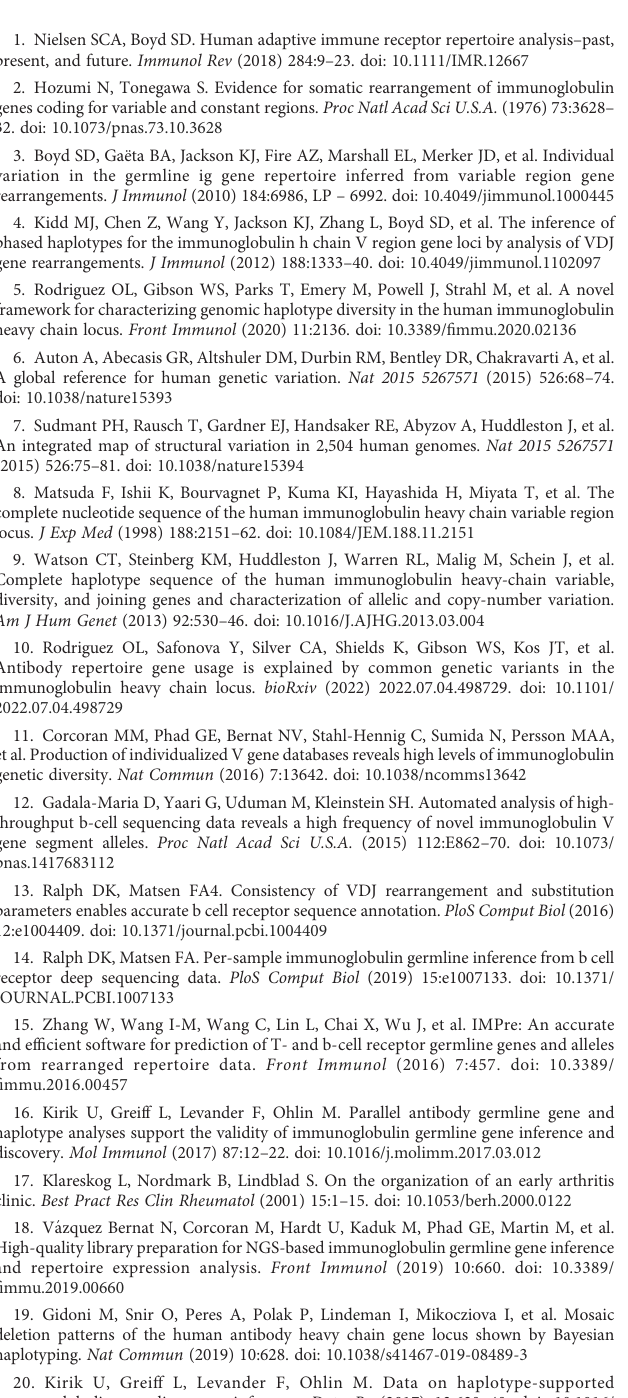
SUPPLEMENTARY FIGURE 2 IGHV genotypes of H9, F8 and G7 including the IGHV4-34*01_S0742